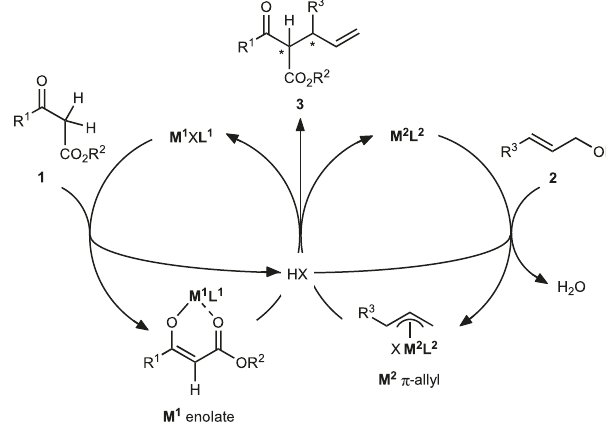
Fig. 2 | Basic strategy for stereodivergent catalytic dehydrative allylation sys- tems. M 1 and M 2 :metalatom ofcomplex. L 1 and L 2 : chiralligand. X: anionic